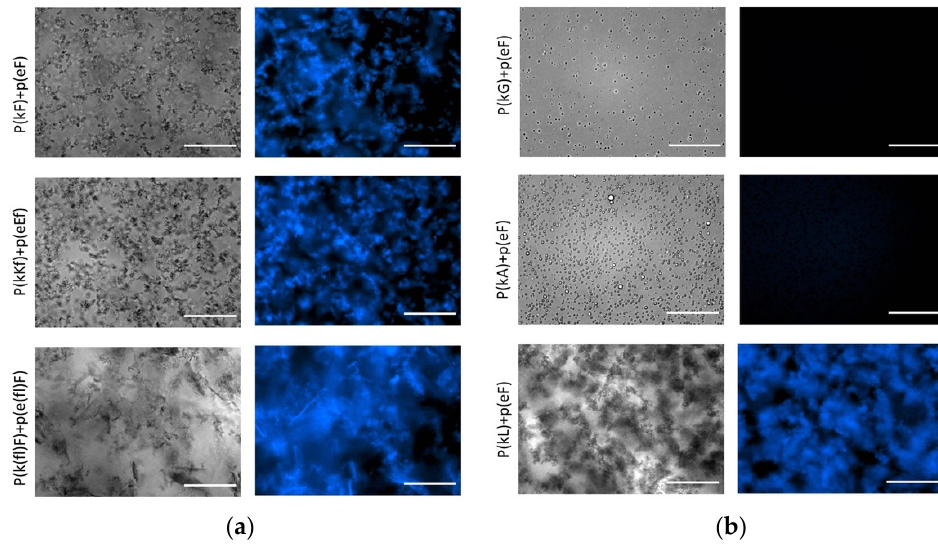
Figure 6. Optical and fluorescence images of complexes with thioflavin T (ThT). The concentration of